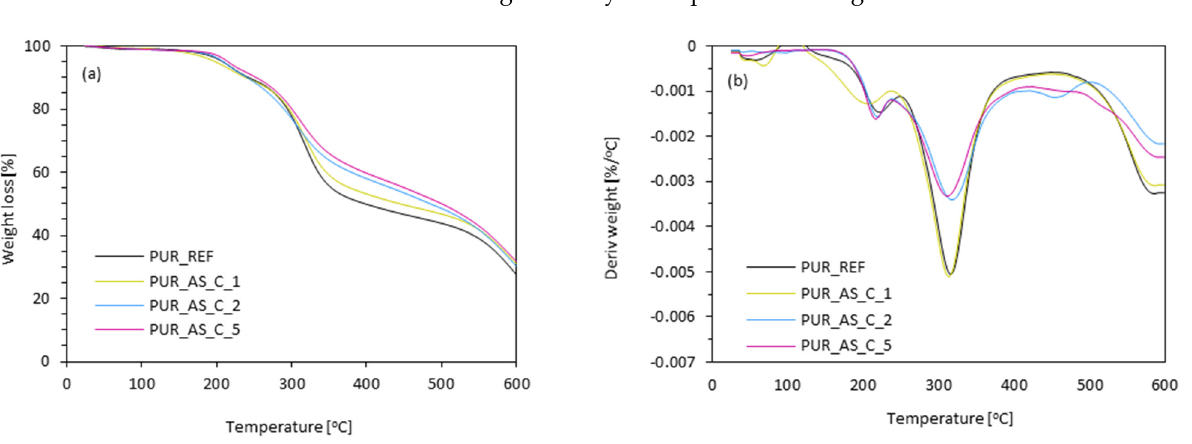
Figure 16. ( a ) Thermogravimetric (TGA) and ( b ) derivative thermogravimetry (DTG) results were obtained for PUR composites reinforced with casein/apricot filler.